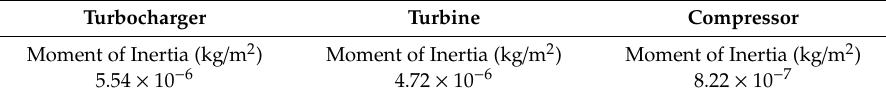
Table 8. Experimentally obtained mass moment of inertia for GT1548 turbocharger.